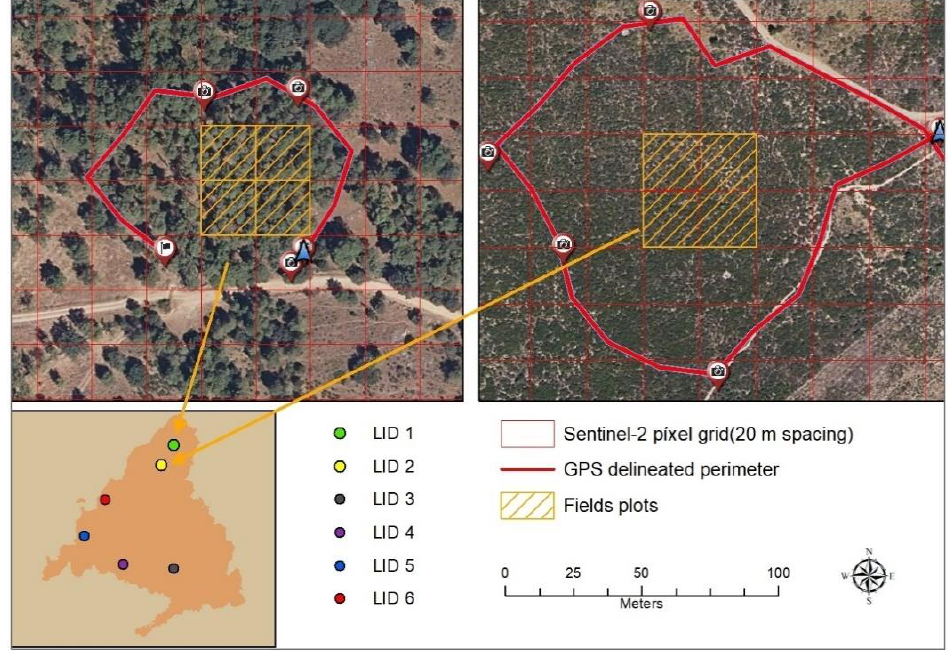
Figure 1. Spatial distribution of sampling locations (LID1 to LID6) within the Madrid region centered at 3.7 W and 40.5 N. Upper panels exemplify plot selection using GPS perimeters and orthophotos (pine — left, rockrose — right).